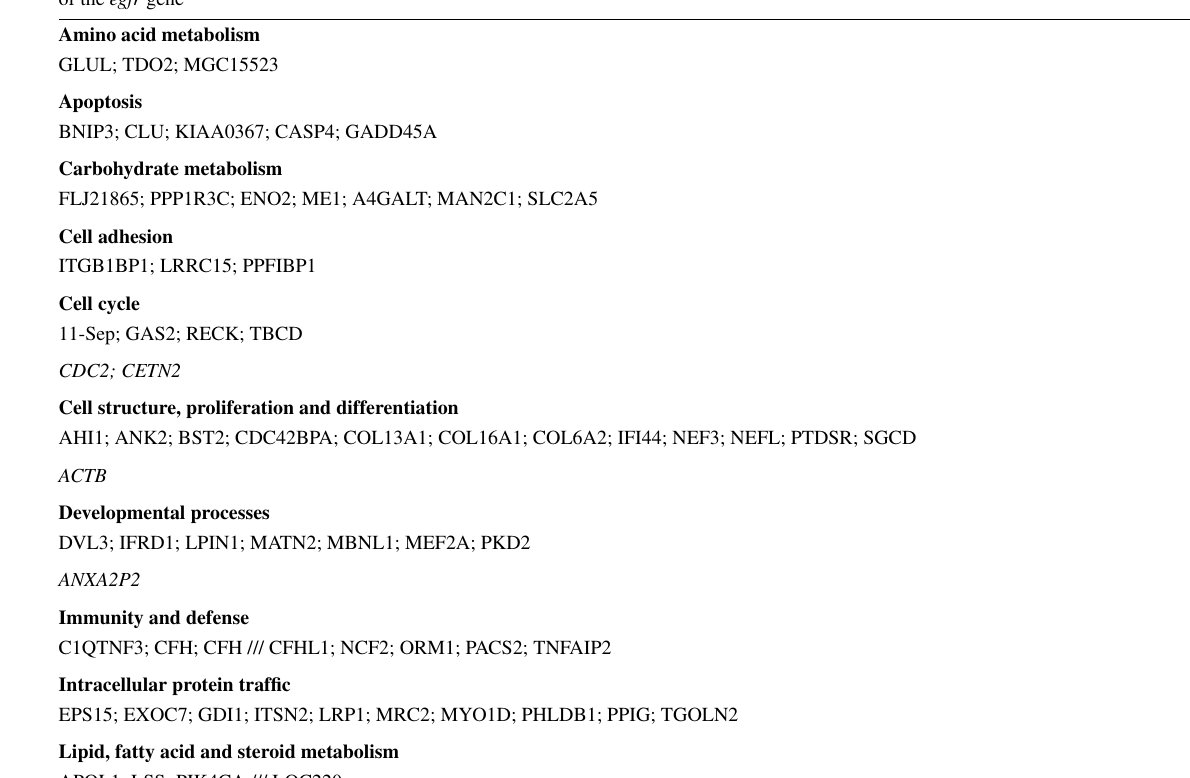
List of candidate genes with upregulation and downregulation (italics) in phyllodes tumours with amplifications including sequences of intron 1 of the egfr